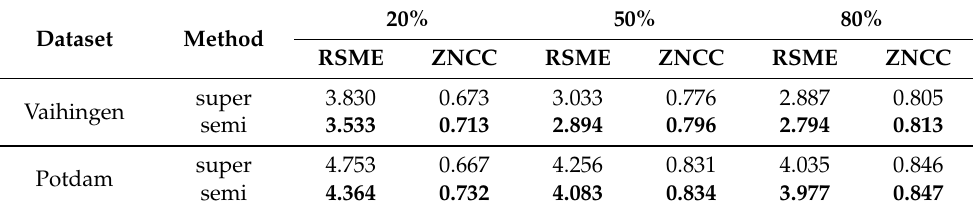
Table 2. Inner-domain semi-supervised learning results compared with the supervised learning mode on datasets of Vaihingen and Potsdam. Best results in each category are in bold.